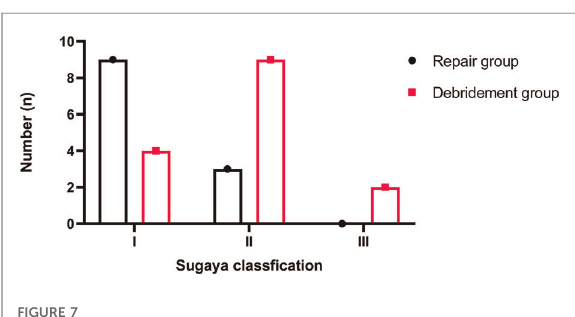
FIGURE 7 Tendon integrity detected by MRI scans according to the Sugaya classi fi cation at fi nal